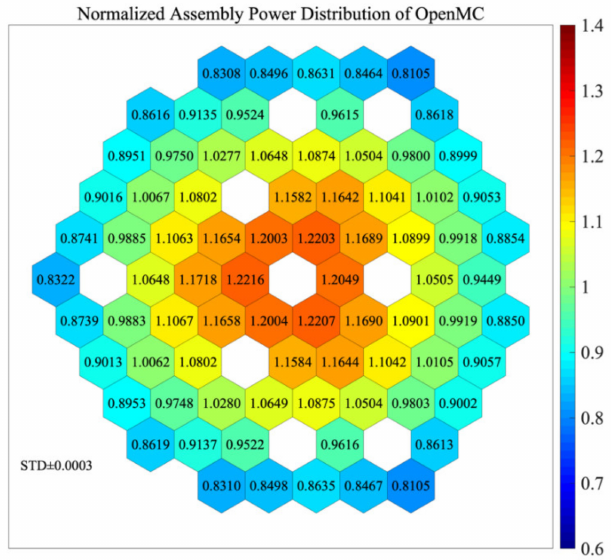
Figure 6. Normalized assembly power distribution of OpenMC at operation loading with control-rod positions of “2 × RE + 3 × SH + 3 × SA Before” ( k eff = 1.00181 ±